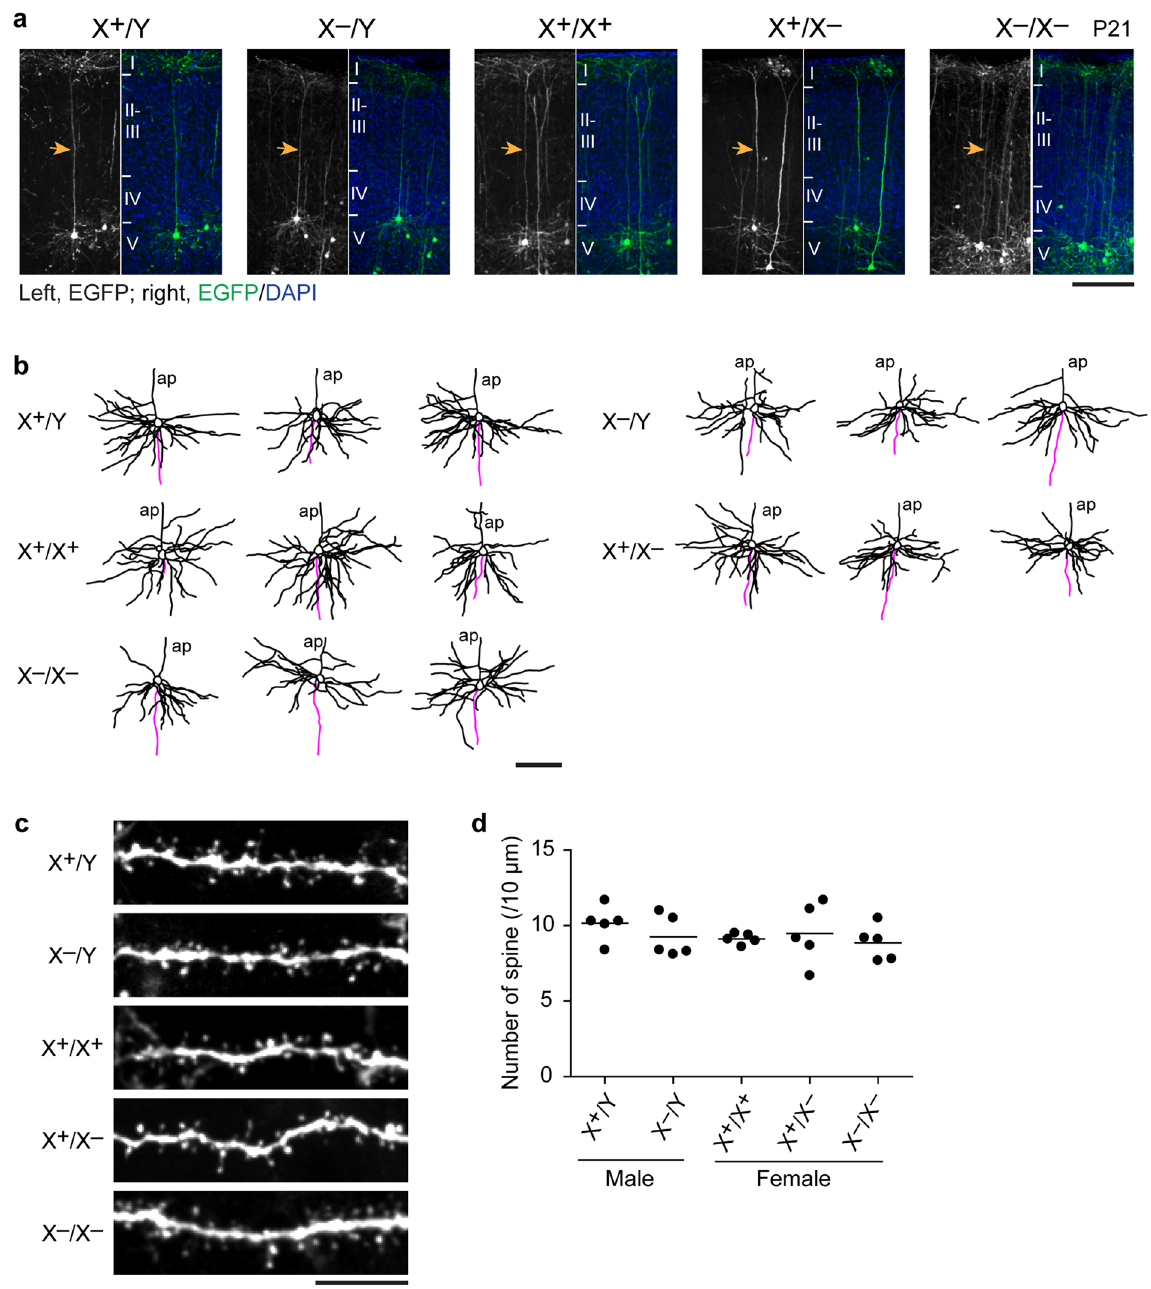
Figure 4. Formation of apical and basal dendrites and spines of layer-Va neurons in Pcdh19 mutants. ( a ) Representative layer Va neurons labeled by in utero electroporation of GFP. Arrows indicate the apical dendrite of each neuron. Brains were fixed at P21. ( b ) Examples of dendritic branches of layer Va neurons. Tracings of dendrites and axons were shown in black and magenta, respectively. ap, apical dendrite. ( c ) Examples of spines along basal dendrites of layer Va neurons. ( d ) Number of spines per 10 μ m along basal dendrites did not significantly differ among wild-type and Pcdh19 mutant mice ( P = 0.6184, n = 5